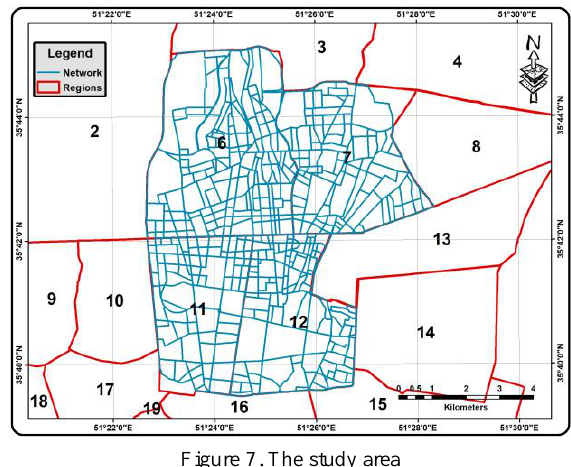
Figure 7. The study area